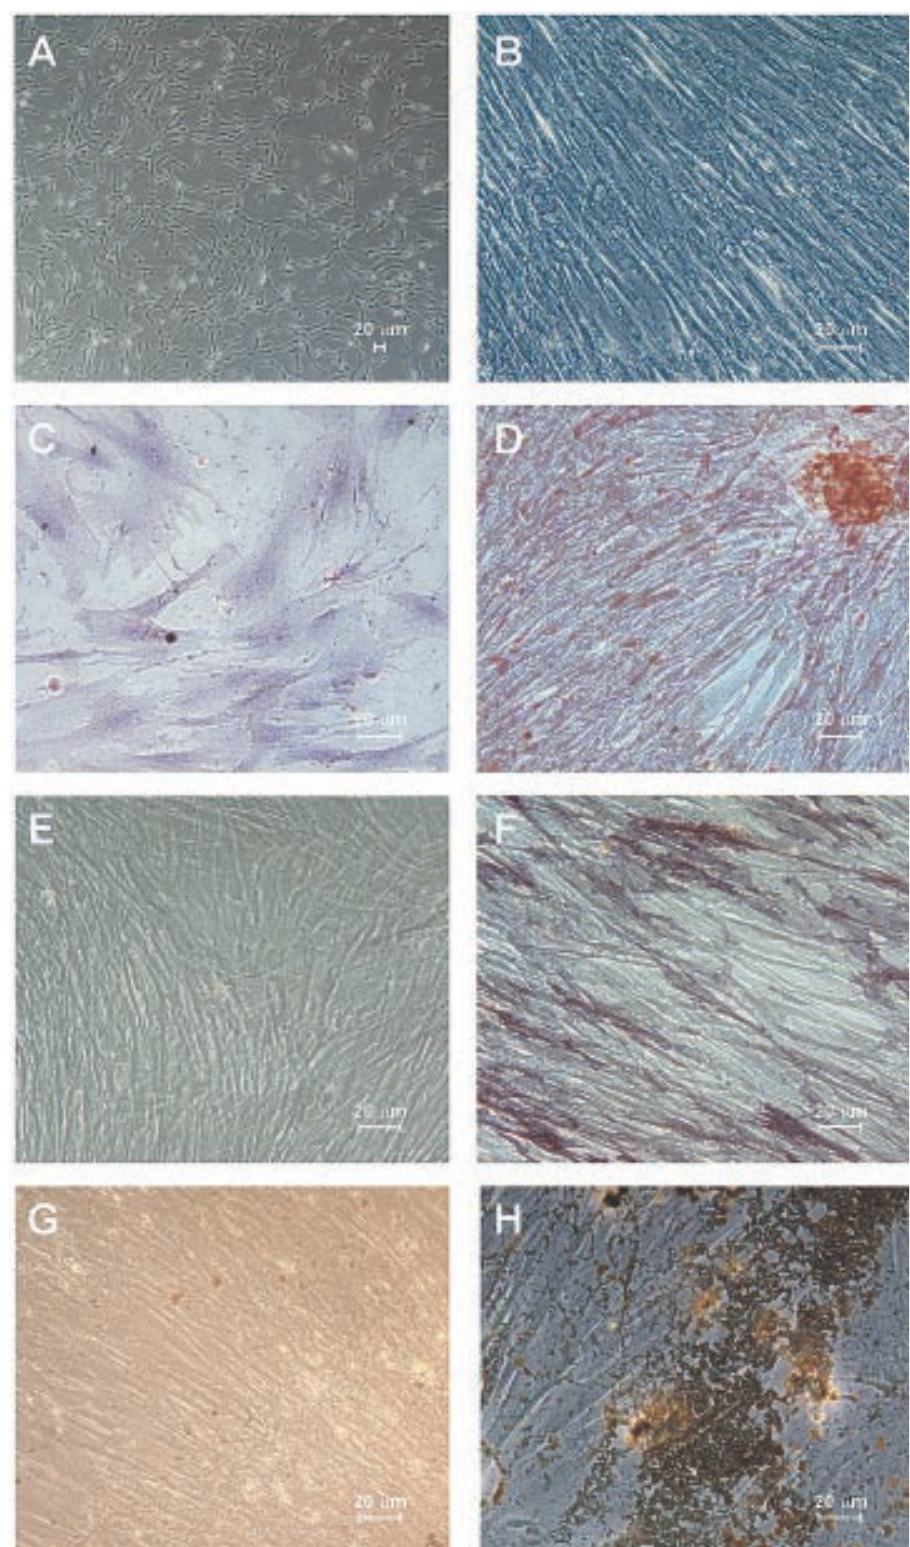
Figure 2. Morphology and dif- ferentiation of umbilical cord vein mesenchymal stem cells (MSC). A , B , Fibroblastoid mor- phological aspect of MSC ob- served by phase microscopy. C , D , Fatty differentiation show- ing nonstimulated (C) and stim- ulated (D) cells stained with Sudan III. The adipocytes pres- ent deeply stained fatty gran- ules. E-H , Osteogenic differen- tiation showing nonstimulated (E and G) and stimulated (F and H) cells stained with alkaline phosphatase (E,F) and with the von Kossa dye (G,H). The os- teocytes are deeply stained. A: 100X. B-H: